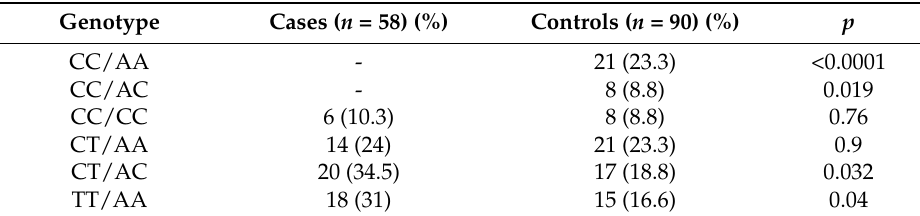
Table 1. Distribution of MTHFR genotypes in OSCC patients and healthy subjects.